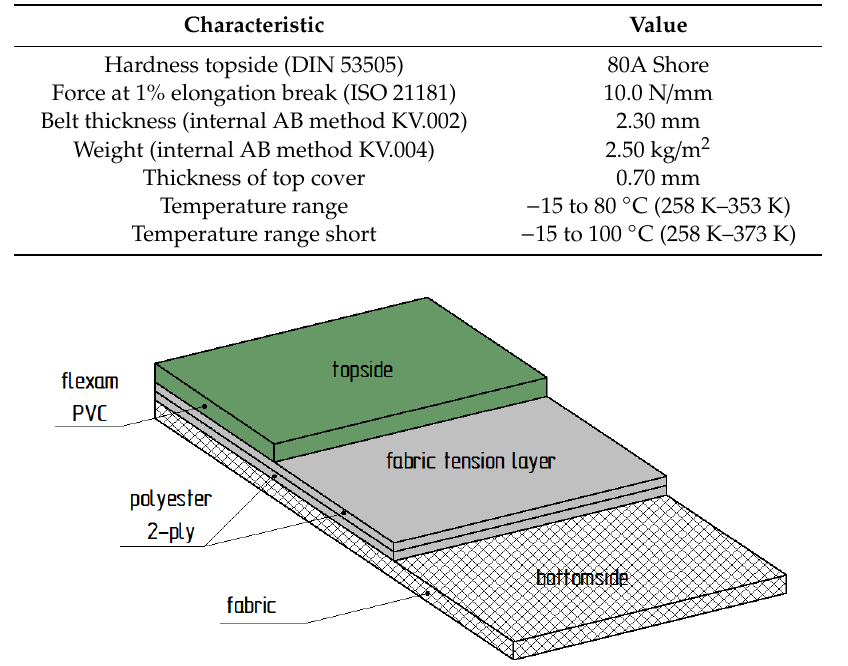
Table 3. Sample exposure data—climatic chamber.